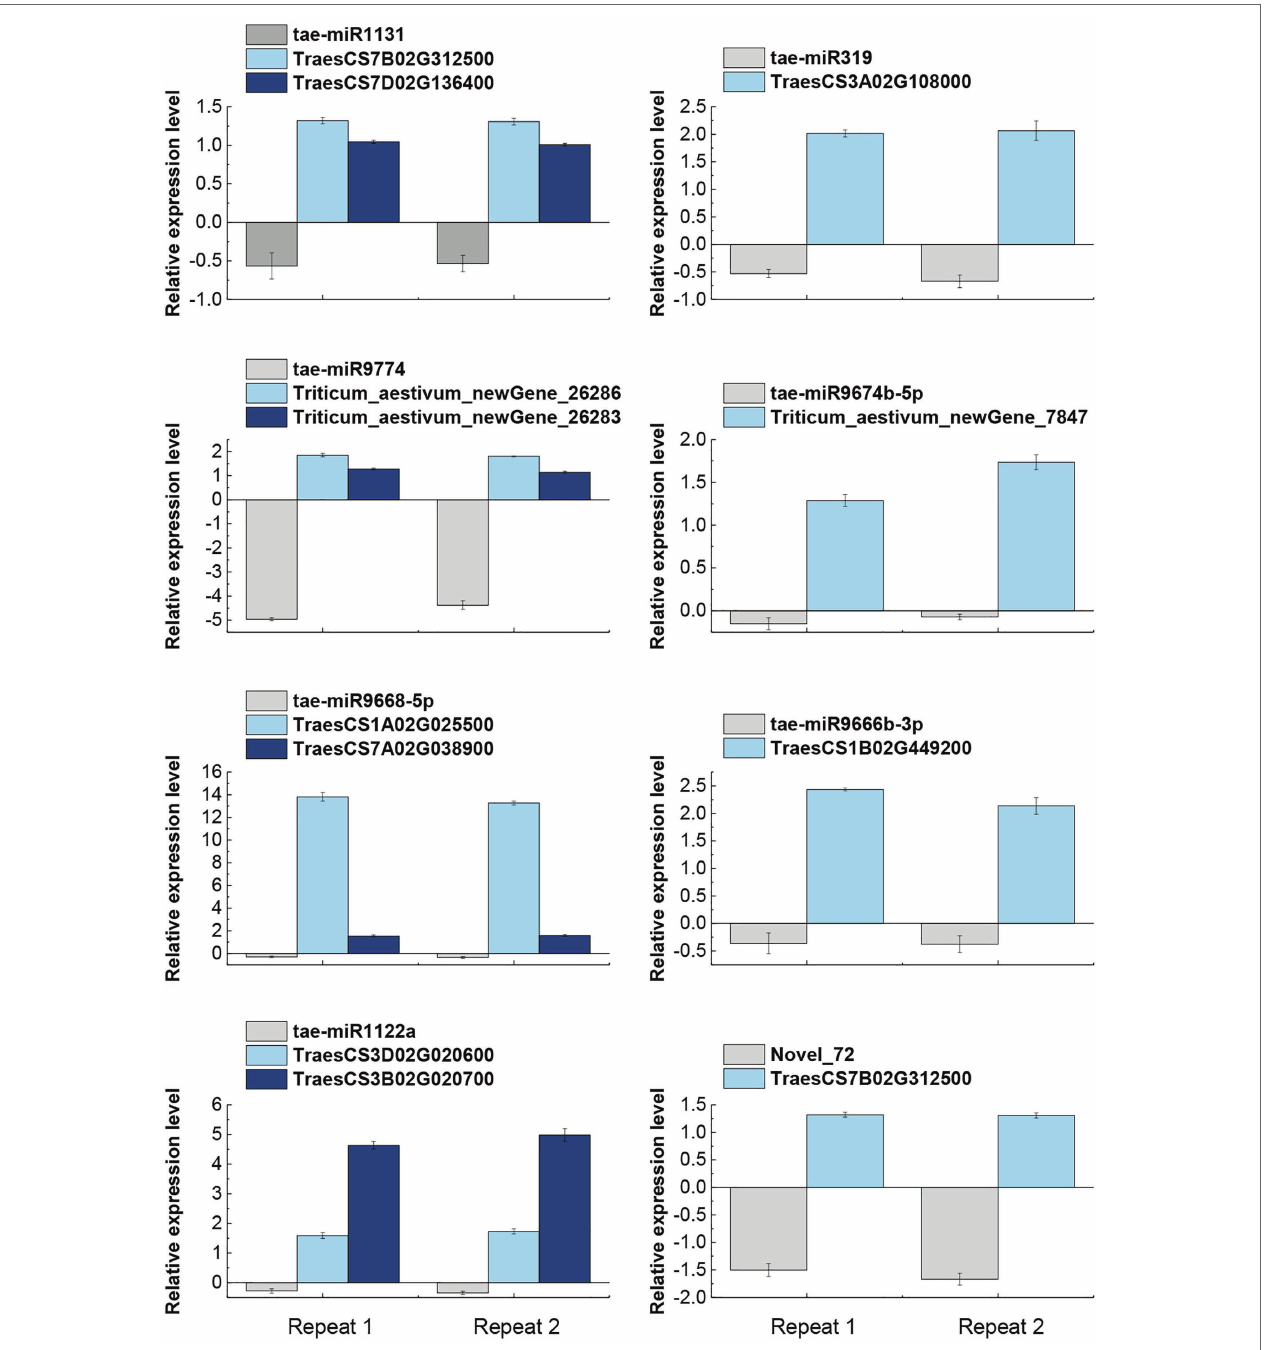
FIGURE 4 | qRT-PCR based validation of miRNAs and their target genes expression pattern in response to salt stress. The expression data are means of three biological replicates and two technical repeats. tae-miR1131, tae-miR9774, tae-miR9668-5p, and tae-miR1122a miRNAs were found to have two target genes each, while tae-miR319, tae-miR9674b-5p, tae-miR9666b-3p, and Novel_72 miRNAs had only one target gene